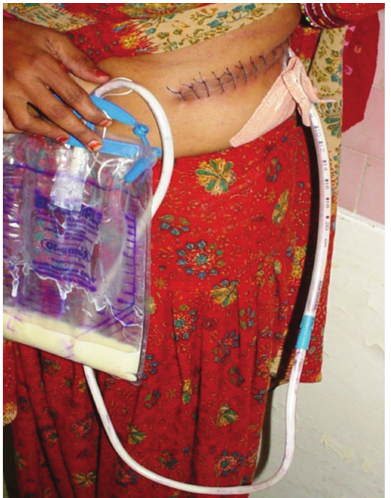
Figure 2: Case number 1 with retroperitoneal drain in situ.